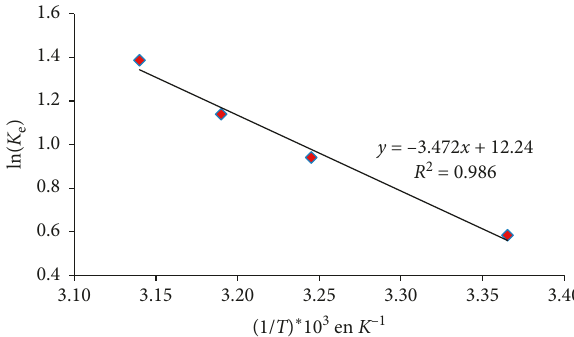
2 ) as a function of 1/